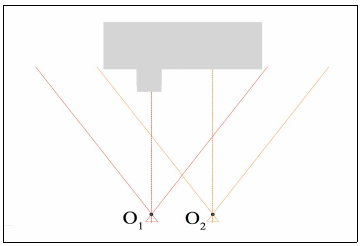
Figure 1. Stereoscopic scheme (planimetric